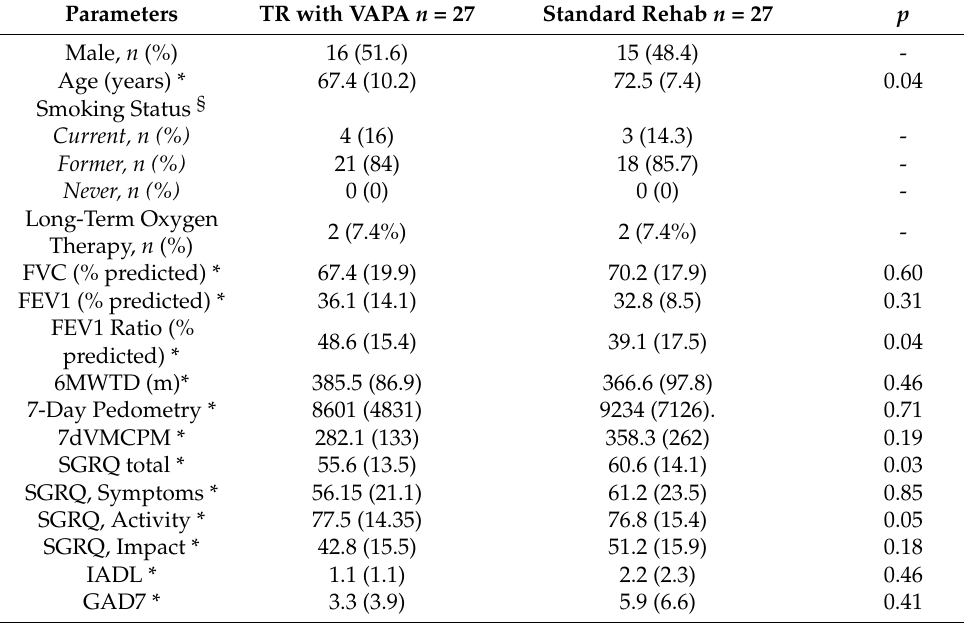
Table 2. Demographics of the 54 patients that took part in the trial at baseline.